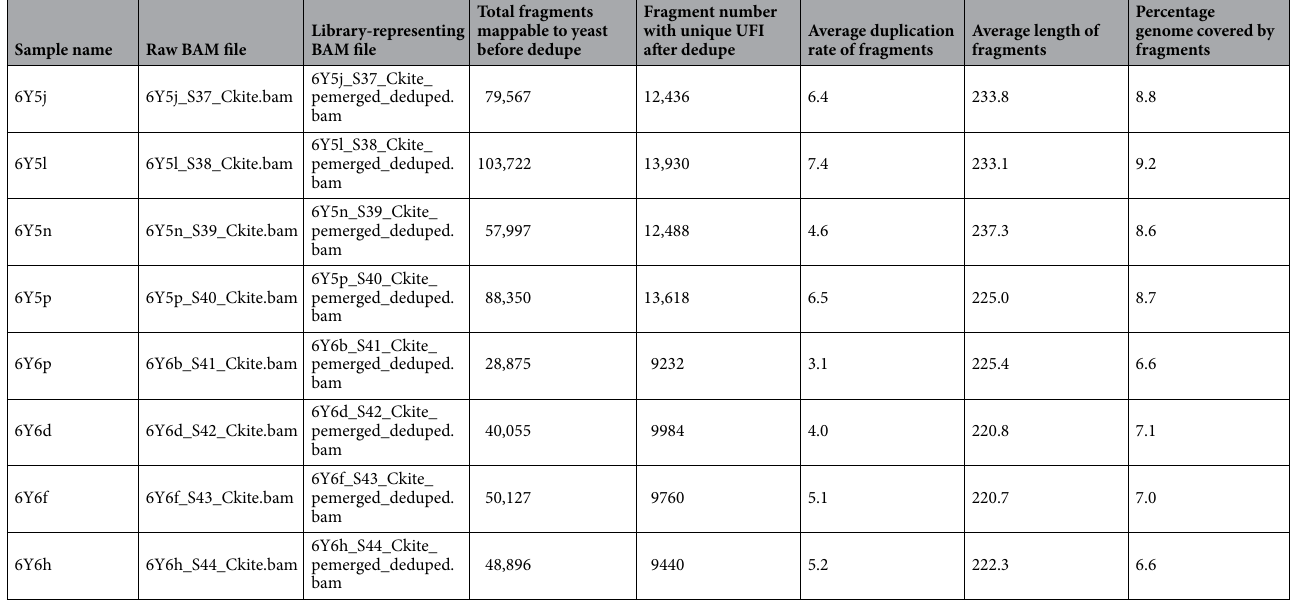
Table 1. Sample names, file names, and sequencing statistics of BIGseq on fractions of yeast genome